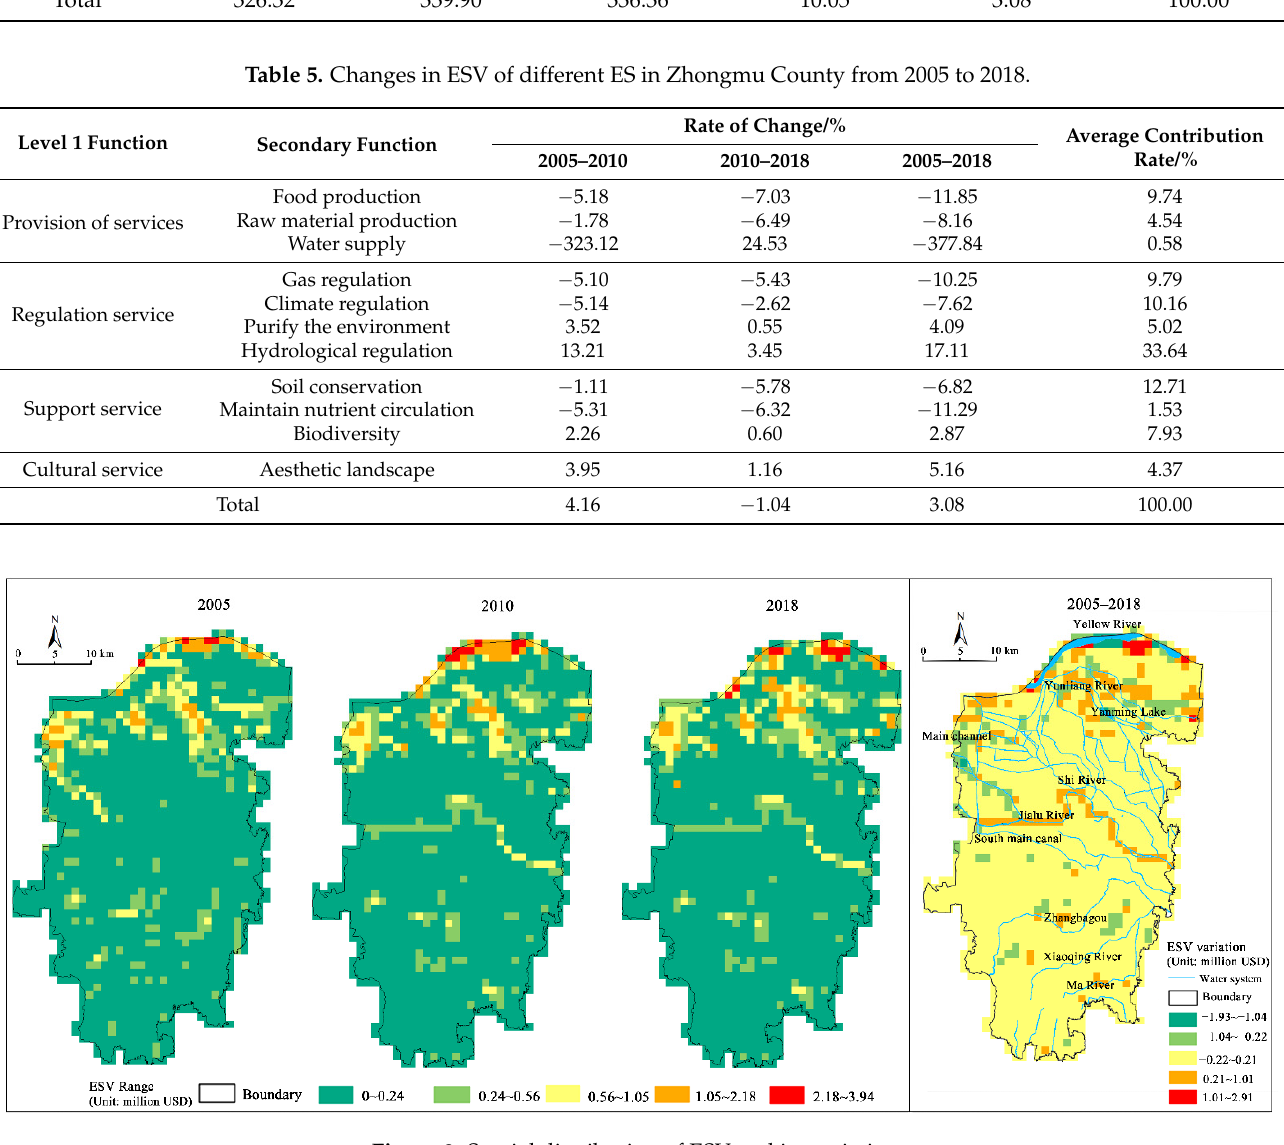
Table 5. Changes in ESV of different ES in Zhongmu County from 2005 to 2018.